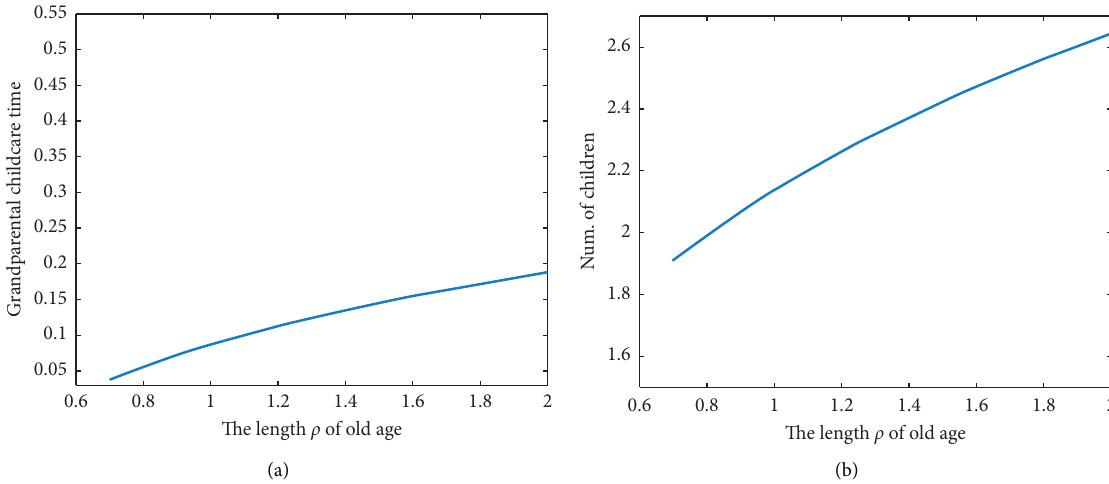
Figure 2: Simulation study of the DGE model with considering intergenerational childcare. (a) The association of length ρ of old age with grandparental childcare time; (b) the association of length ρ of old age with the number of children of their